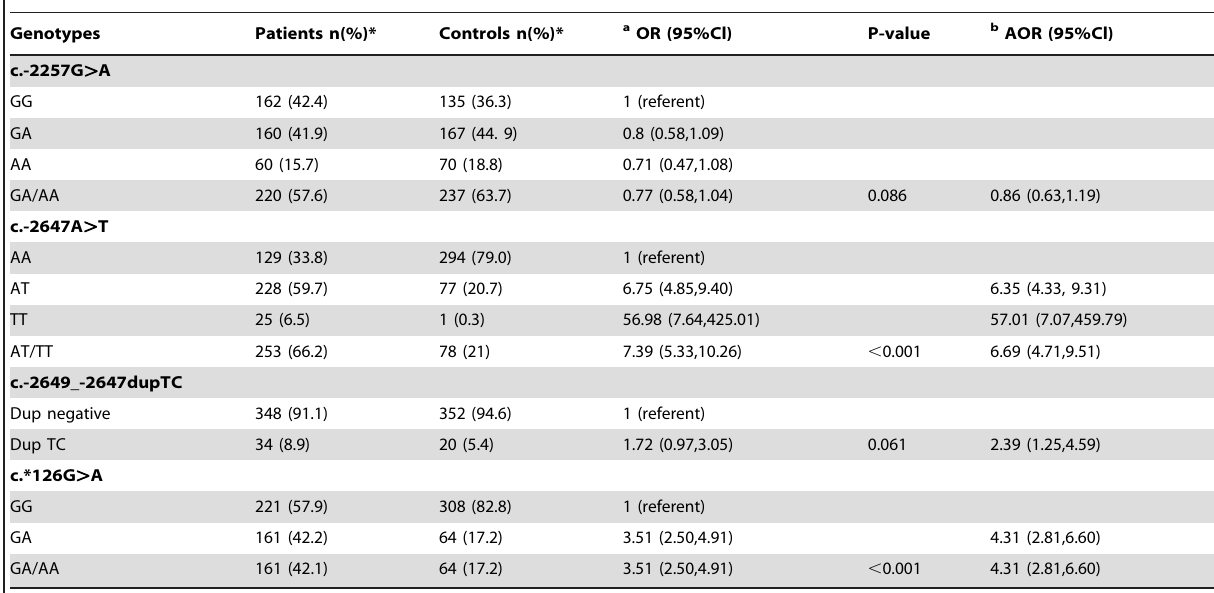
Table 4. Association between FoxC2 genotypes (novel) and CVD